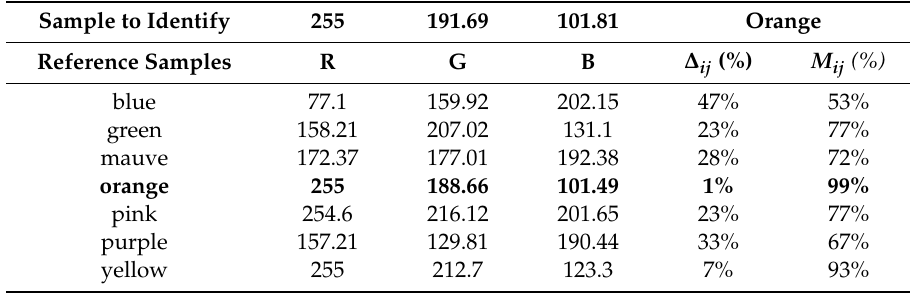
Table A5. Identification of a sample (orange paper) using a CaliPhoto database. The best match occurs for the orange paper, which has a matching percentage M ij = 99%. The second-best match occurs for the yellow paper which, to the human eye, is not very different from the orange paper.